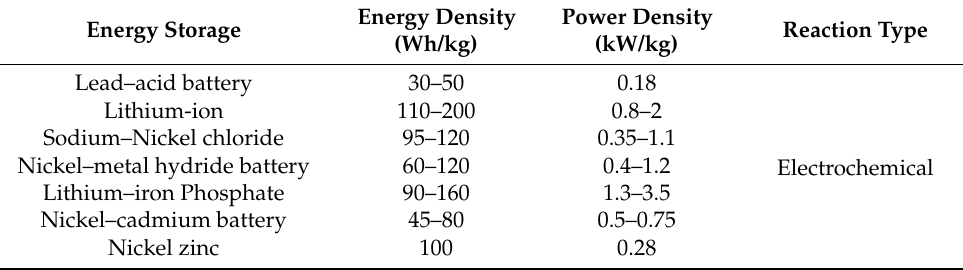
Table 6. Performance comparison of different types of